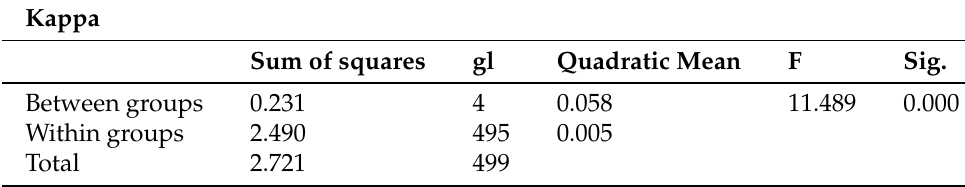
Table 6. ANOVA test in Cohen’s Kappa